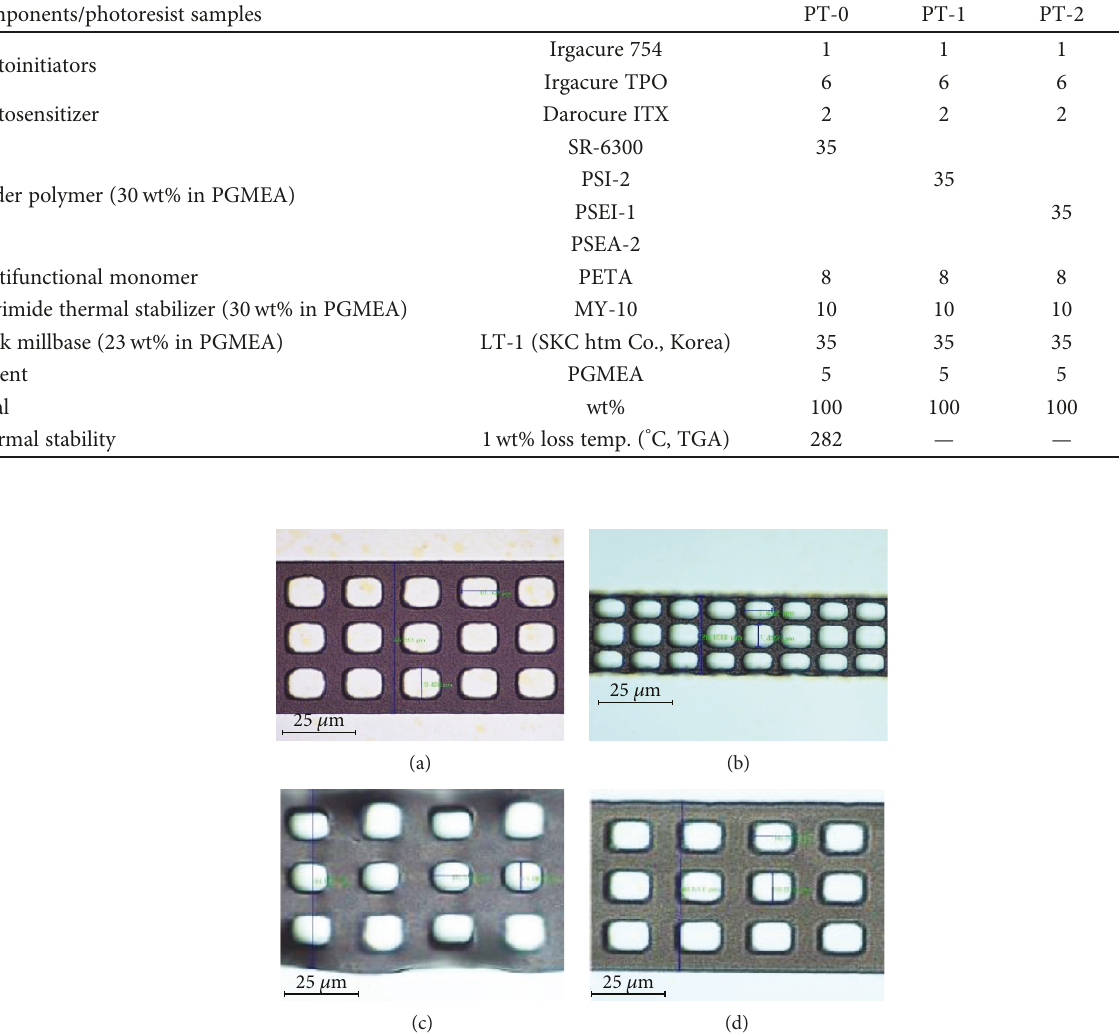
Figure 8: The optical microscopic images of black PDL patterns obtained with (a) PT-0, (b) PT-1, (c) PT-2, and (d) PT-3 black photoresists.